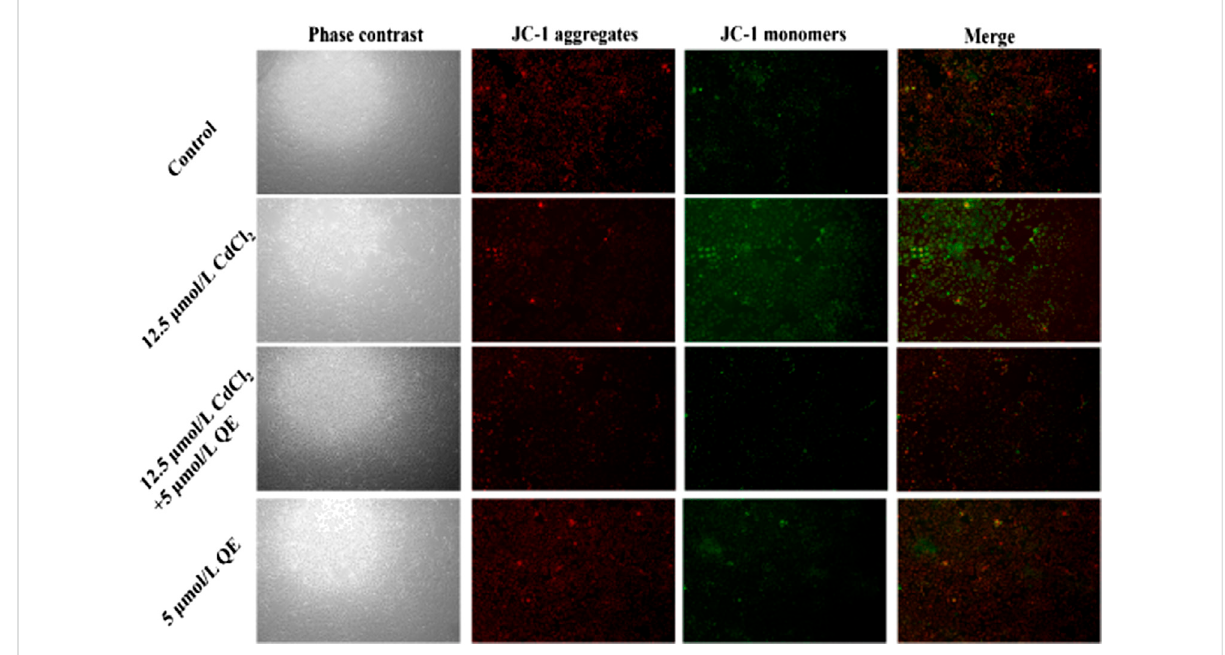
FIGURE 7 Effects of QE on mitochondrial-membrane potential in Cd-induced BRL-3A